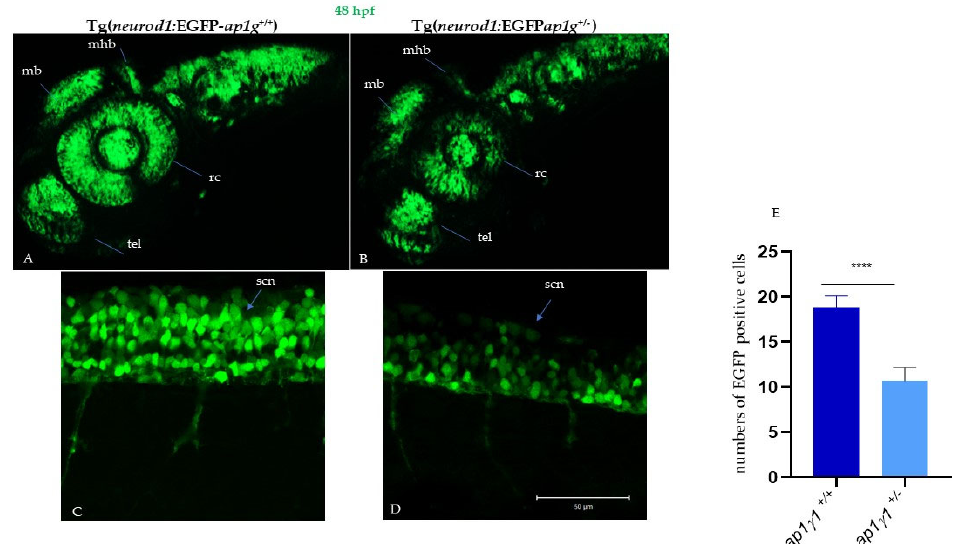
Figure 5. Neuronal characterization of ap1g1 +/+ and ap1g1 +/ − embryos: Confocal images of ap1g1 +/+ and ap1g1 +/ − embryos in transgenic background tg( neurod1 :EGFP) 48 hpf. Lateral view of the central nervous system ( A ) and of spinal cord neurons ( B ) acquired using an LSM510 Meta confocal microscope (Zeiss (Oberkochen, Germany). ( A , B ) Images were acquired using a Plan-Neofluar 10X/0.3NA objective. A Z-stack was performed to acquire the whole central nervous system and Maximum Intensity Projection was obtained using Zen Black software. Abbreviations: mb, midbrain; hb, hindbrain; mhb, midbrain–hindbrain boundary; tel, telencephalon; rc, retinal cells; snc, spinal cord neurons. Single plane images were acquired using a PlanApochromat-63X/1.4 NA oil DIC objective. Size bar: 50 µ m. ( C , D ) EGFP-positive cells were quantified by drawing polygonal regions on the image acquired and manually counting the number of cell somas in the selected area. The analysis is the result of 3 different experiments with n = 15 for each genotype. ( E ) Quantification of EGFP positive cells in the described spinal cord area described in figure C and D; **** p < 0.0001, Student’s t